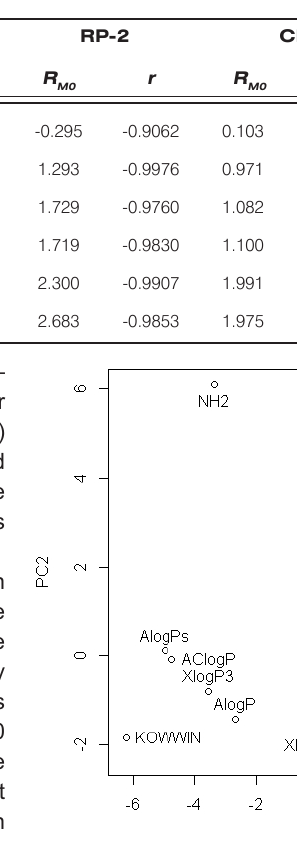
Table 2. The R values and correlation coefficients obtained for reference compounds. M0